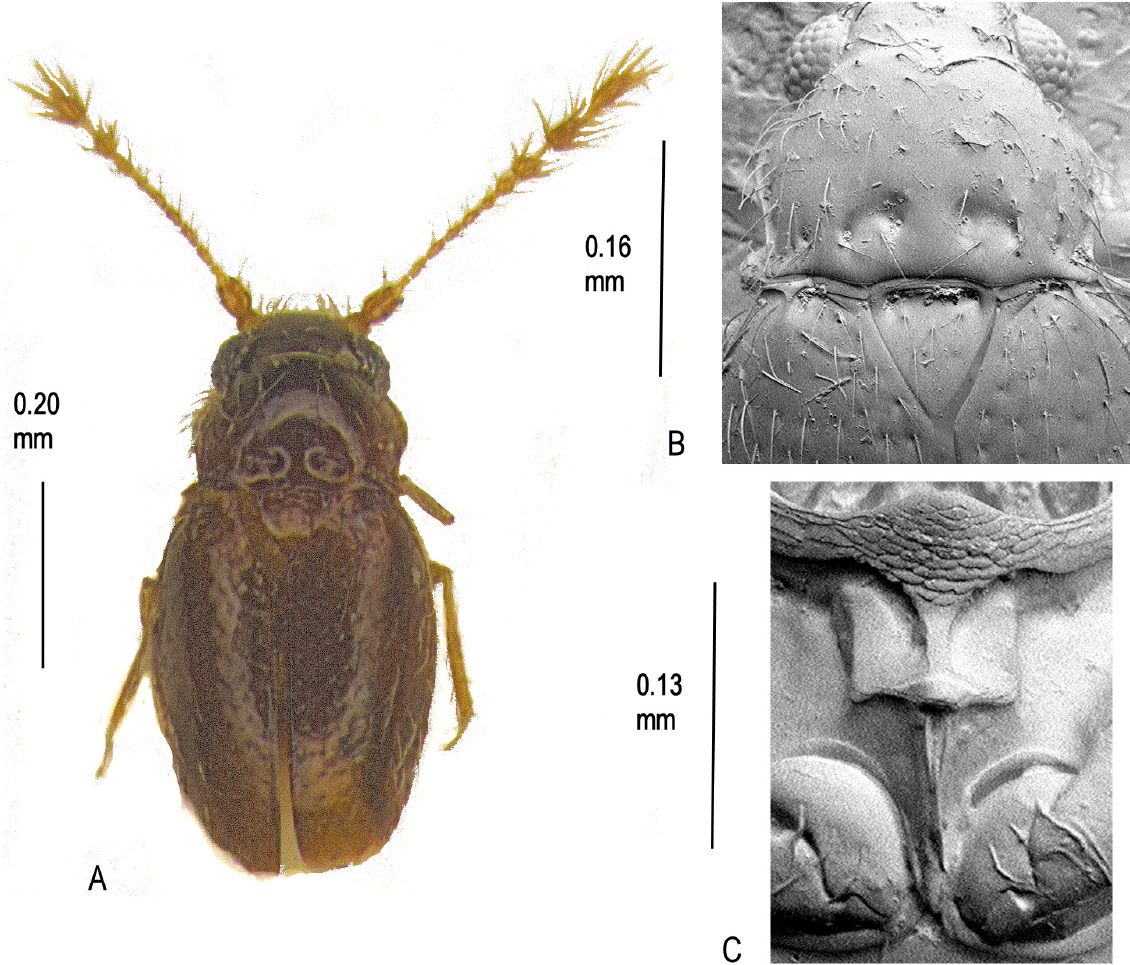
Fig. 34 . Cissidium misellum sp. nov. A . Habitus. B . Pronotum, × 550. C . Mesoventrite showing median process of collar, mid-keel and keel, ×